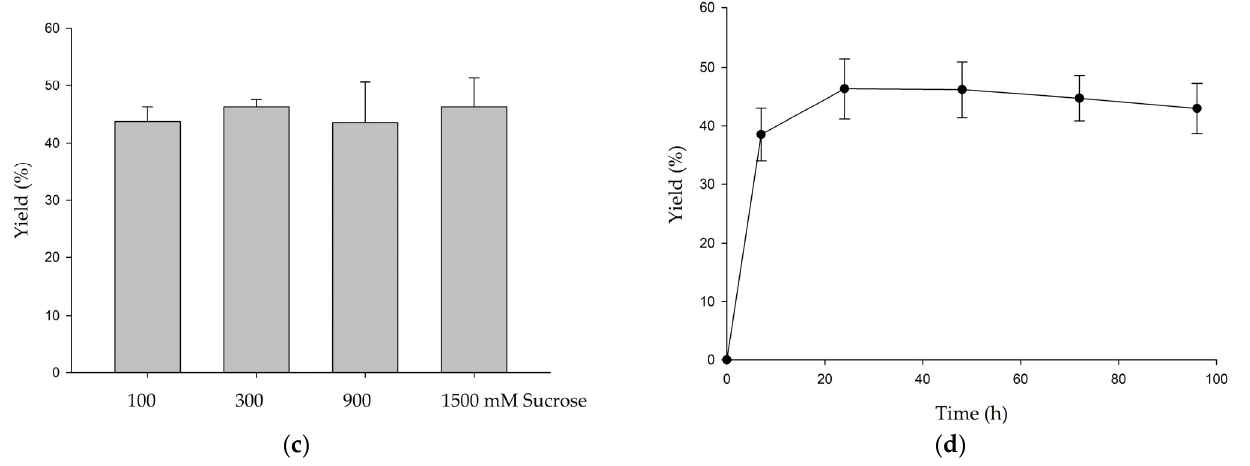
Figure 2. Effects of pH ( a ), temperature ( b ), sucrose concentration ( c ), and reaction time ( d ) on the yield of compound ( 1 ) from biotransformation of ganoderic acid F (GAF) by Dg AS. The standard reaction condition was 1 mg/mL of GAF, 25 µg/mL of Dg AS, and 1500 mM of sucrose at 50 mM of acetate buffer (pH 5) and 40 °C for 24 h. To determine suitable reaction conditions, different pH values, temperatures, sucrose concentrations, and reaction times were tested. After incubation, the biotransformation products were analyzed using HPLC. The detailed reaction conditions and the HPLC procedure are described in the Section 2.